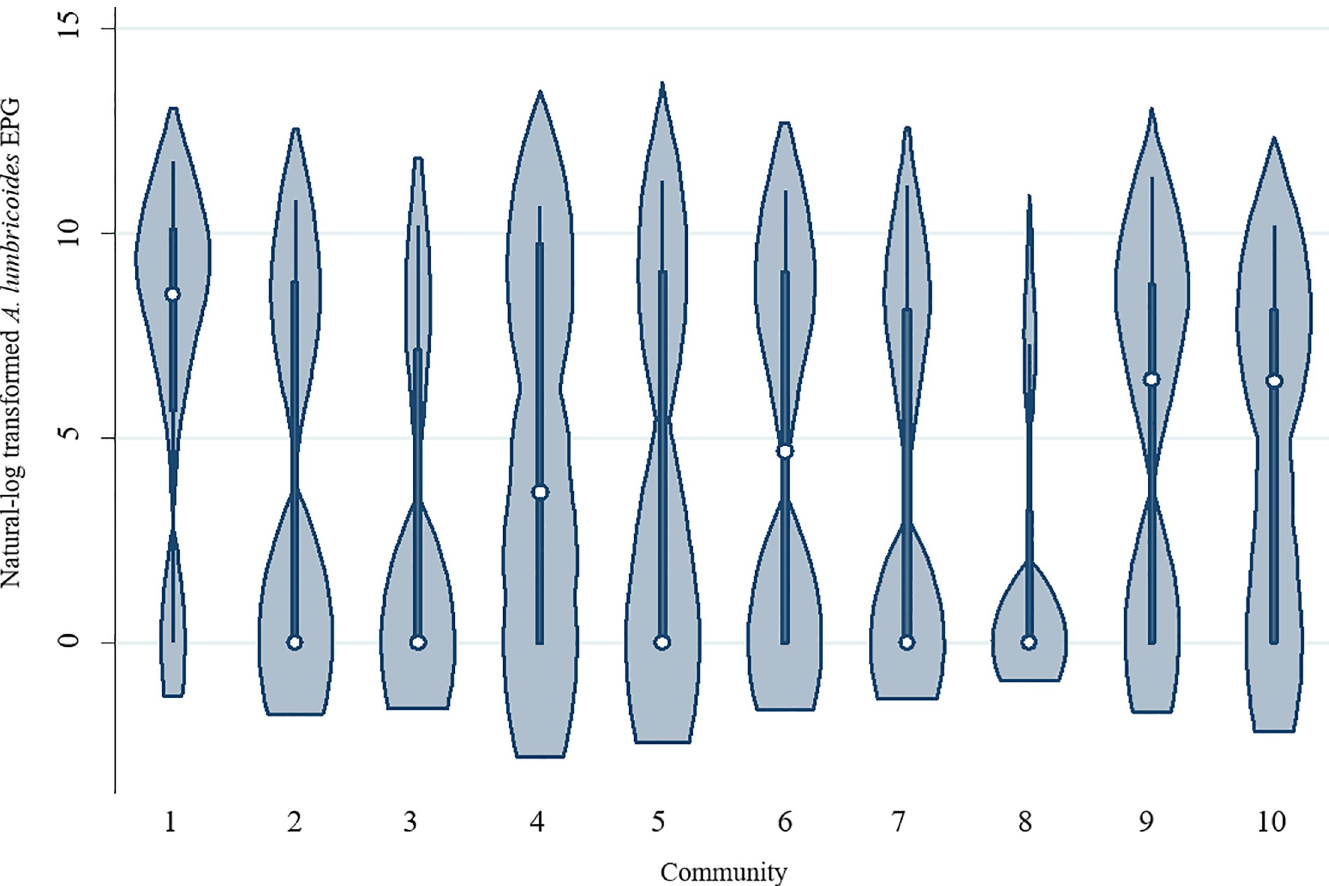
Fig 2. A . lumbricoides infection intensity values by community. Violin plots depicting A . lumbricoides eggs per gram (EPG) infection intensity values by community. The white circle marks the community median, the box indicates community interquartile range, with whiskers extending to the upper and lower-adjacent values. Overlaid shape reflects the probability density of the data at different EPG values. Communities are listed in order of median household style of life scores, which serves as an approximation of community market integration level. Community median style of life scores are presented from lowest to highest (i.e., community 1 has the lowest median score, while community 10 has the